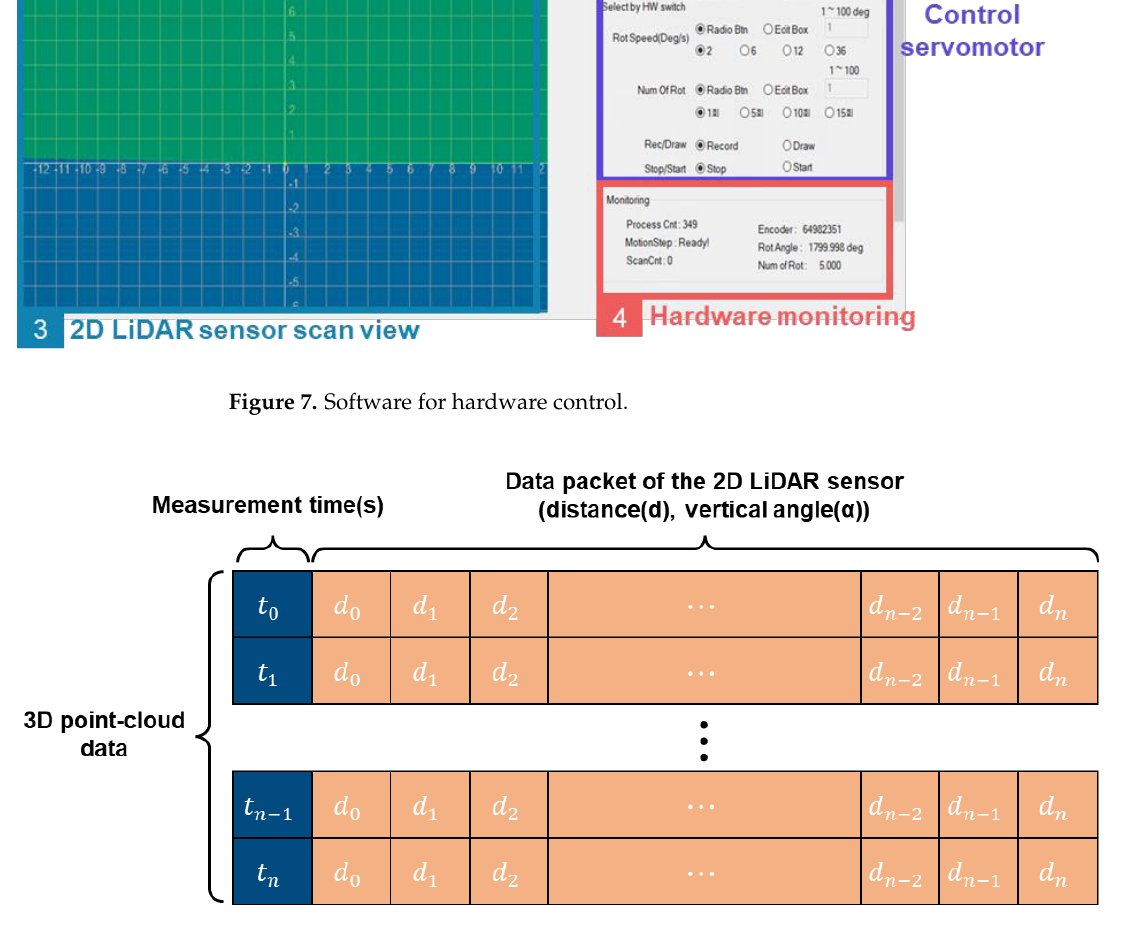
Figure 7. Software for hardware control.